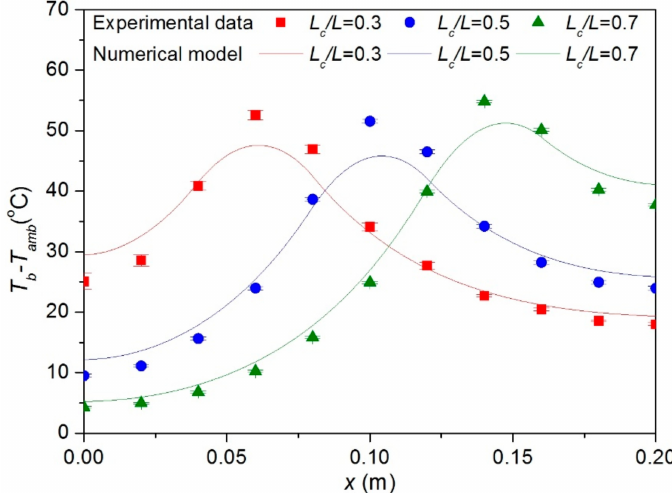
Figure A2. Comparison of temperature di ff erences from experimental data and results of the numerical model for L h / L of 0.2, channel width of 7 mm, and flow rate of 0.2 m 3 /